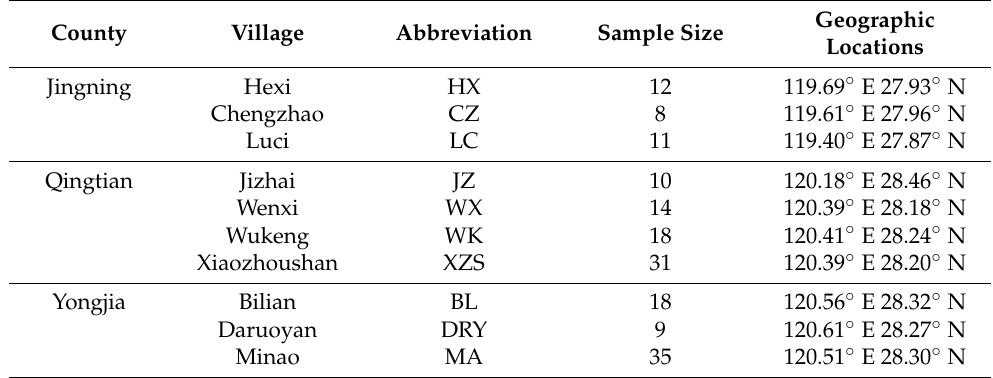
Table 1. Collection details for C. carpio cocultured in paddies in the south of Zhejiang Province,